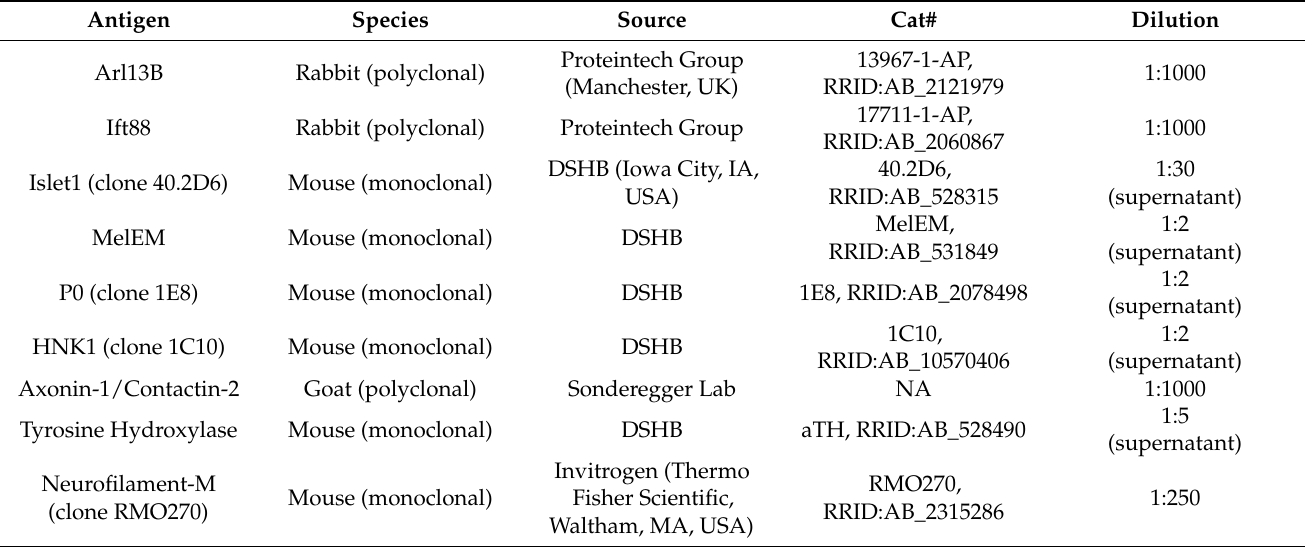
Table 2. List of primary antibodies used for immunohistochemistry and immunocytochemistry. Antigen